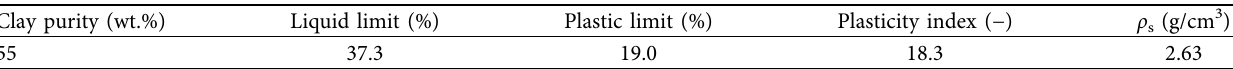
Figure 2: (a) Grain size distribution of FSand NE34 and K Clay represented by the cumulative passing as a function of particle diameter; (b) Passing fraction as a function of particle diameter for the K Clay dispersed and nondispersed. Table 2: Characteristics of K clay from